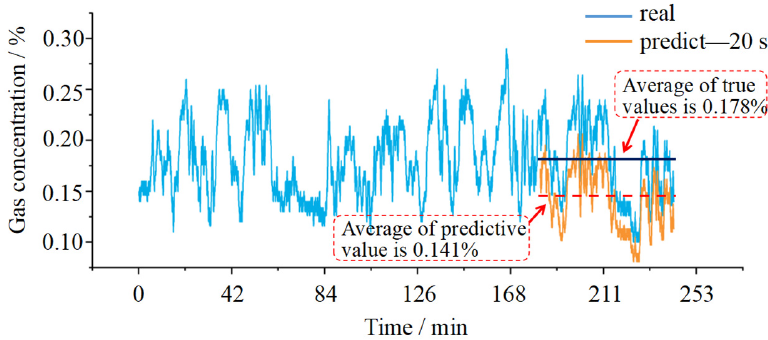
Figure 7. Gas concentration prediction of the model with an update period of 20 s.